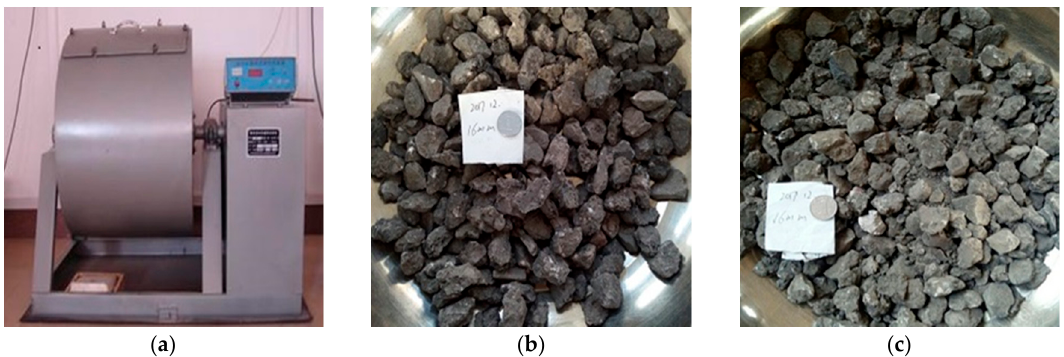
Figure 2. Samples before and after the Cantabro-crushing test, ( a ) Cantabro-crushing test apparatus; ( b ) Samples before the test; ( c ) Samples after the test.